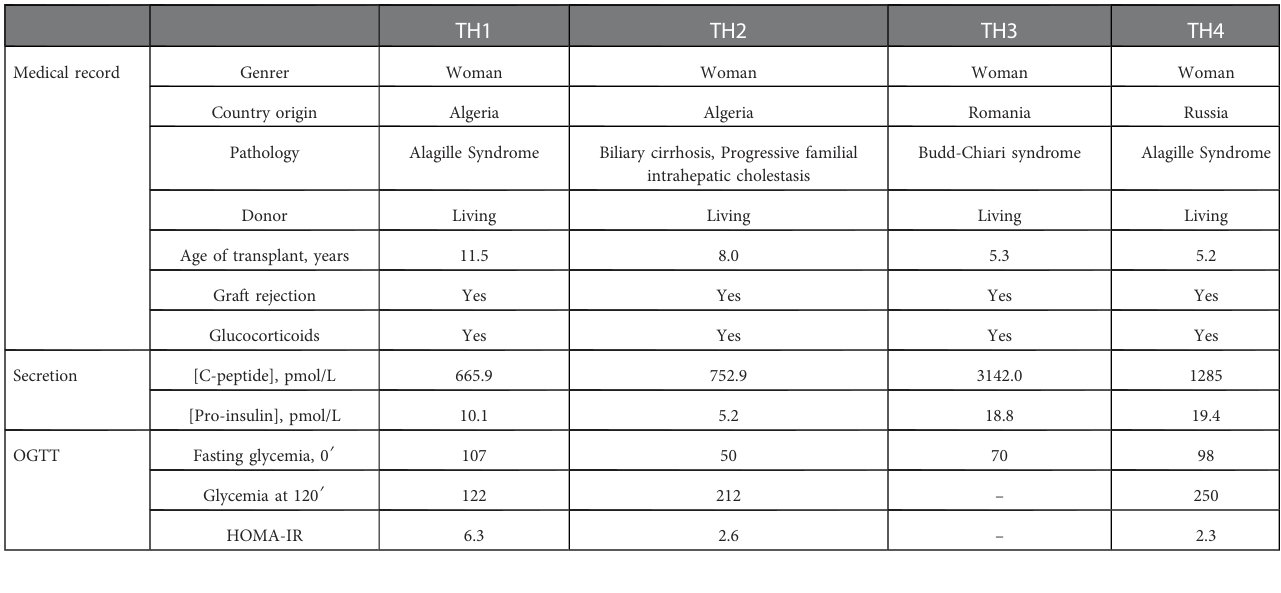
TABLE 5 Pathology and glycemic pro fi le data of LT cohort (pDIABGRAFT).